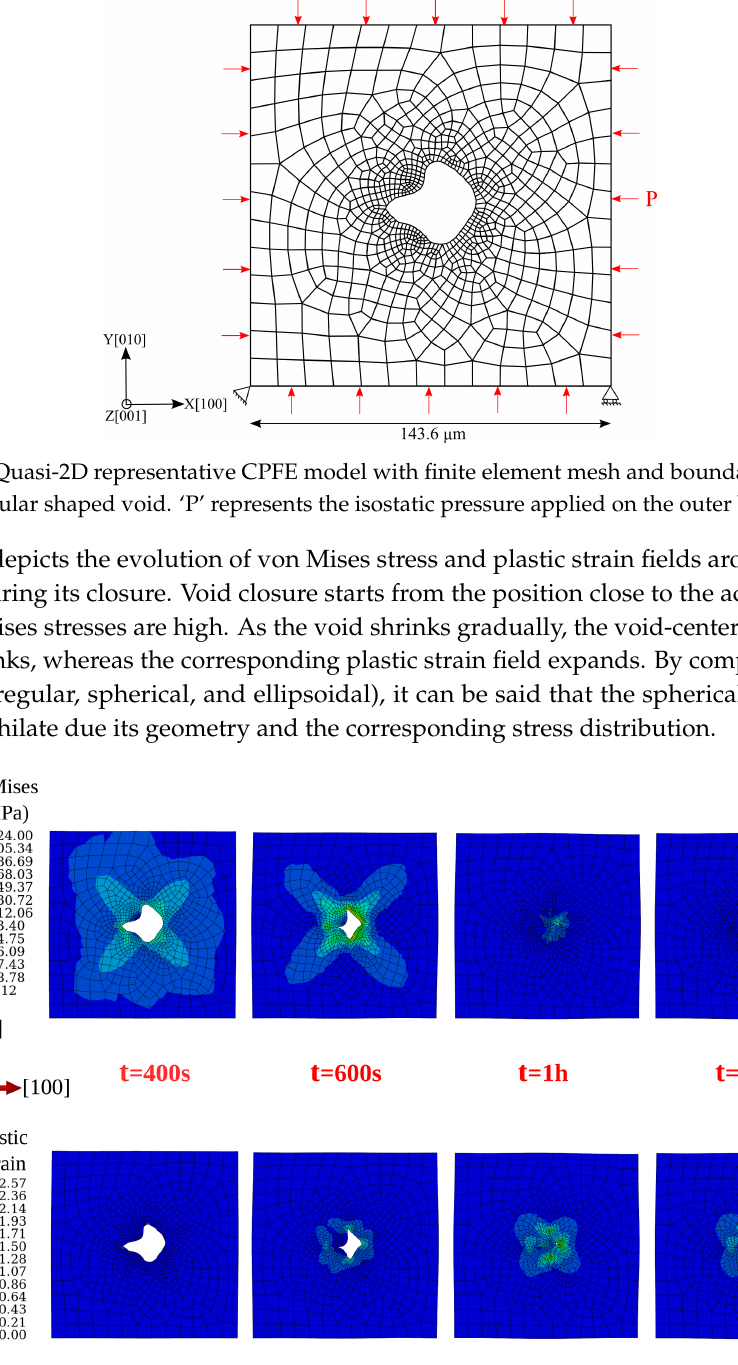
Figure 13. von Mises stress ( a ) and plastic strain ( b ) evolution around irregular-shaped void (Quasi-2D) with increasing simulation time under 100 MPa isostatic pressure at 1561